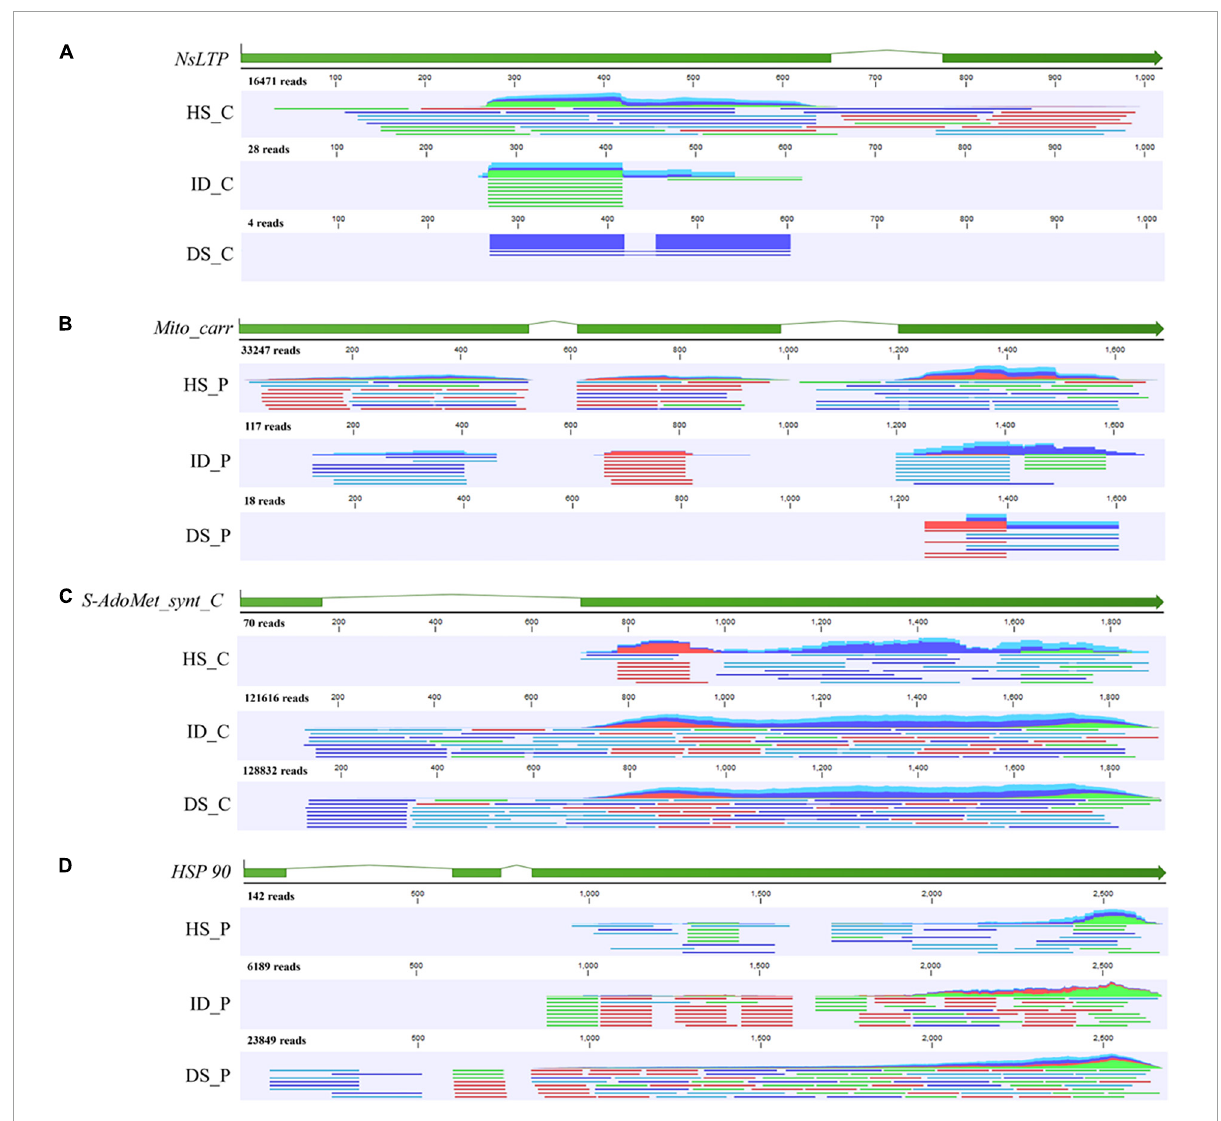
FIGURE7 Mapping track of four selected genes with HiSeq data of different tissue types. (A) Mapping track of citrus NsLTP ( Non-specific lipid transfer protein , citrus to dodder); (B) Mapping track of periwinkle Mito_carr ( mitochondrial carrier , periwinkle to dodder); (C) Mapping track of dodder S-AdoMet_synt_C ( S-adenosylmethionine synthetase C-terminal domain , dodder to citrus); (D) Mapping track of dodder HSP 90 ( Heat shock protein 90 , dodder to periwinkle). Reads mapping was performed by CLC Genomic Workbench 19.0. The sample name of HiSeq data was listed in the left of mapping track. HS_C: citrus stem. ID_C: interface region of dodder’s attachment site in citrus-dodder system. DS_C: dodder stem in citrus-dodder system. HS_P: periwinkle stem. ID_C: interface region of dodder’s attachment site in periwinkle-dodder system. DS_P: dodder stem in periwinkle-dodder system. The green bar indicated the exon region of gene. In mapping track schematic diagram, the dark blue line represents the forward paired read. The light blue line represents the reverse paired read. The green line represents the forward unpaired read. The red line represents the reverse unpaired read. The total number of mapped reads was listed above the mapping